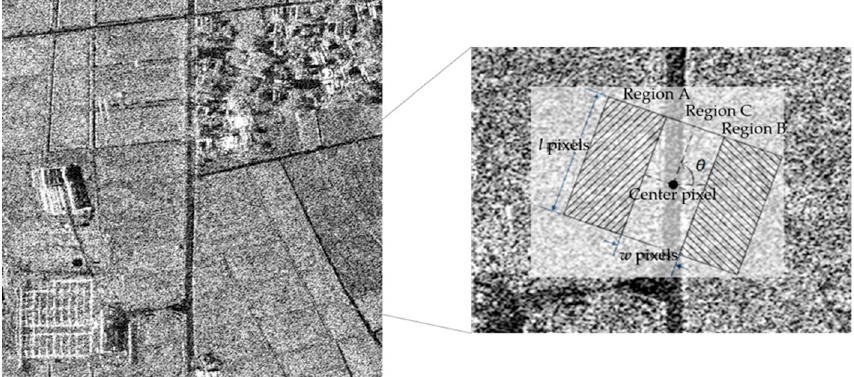
Figure 2. Test image and sketch map of sliding window specified by the rotation angle θ , width w , and length l .